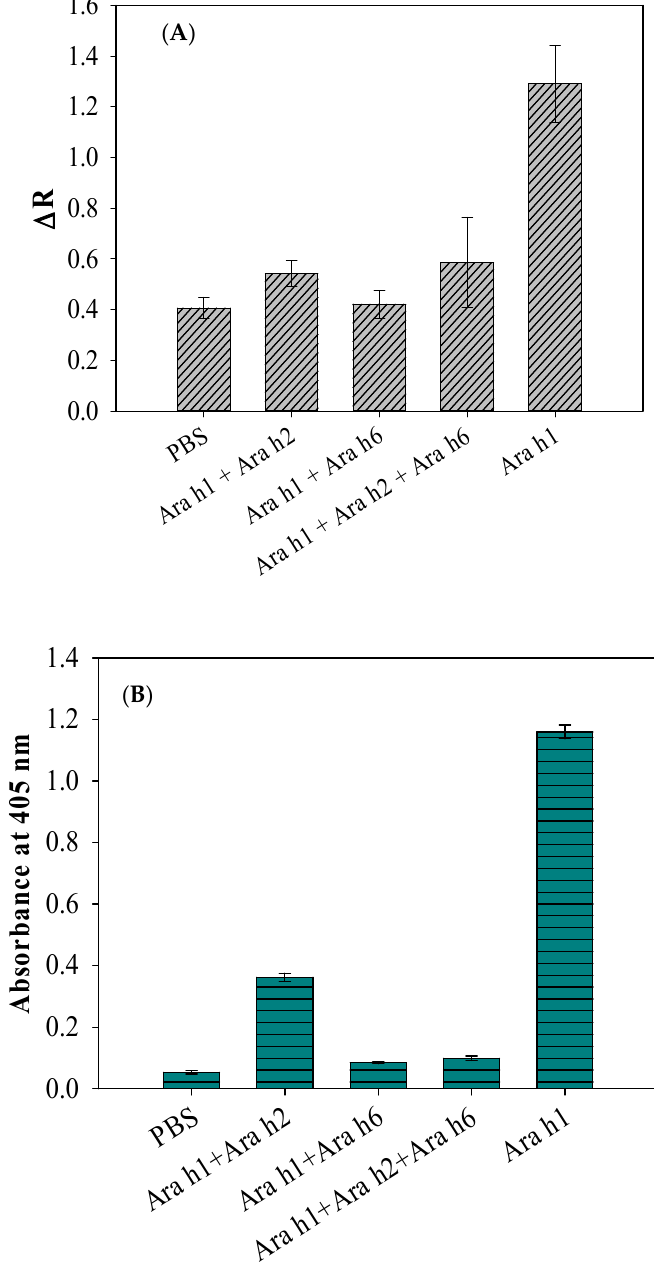
Figure 2. ( A ) Inhibition of Ara h1-binding with anti-Ara h1 pAbs determined by the SWCNT-based biosensor. ( B ) Inhibition of Ara h1-binding with anti-Ara h1 pAbs determined by indirect ELISA. Results are presented as the average ± standard deviation (n = 3); PBS indicates phosphate buffered saline.